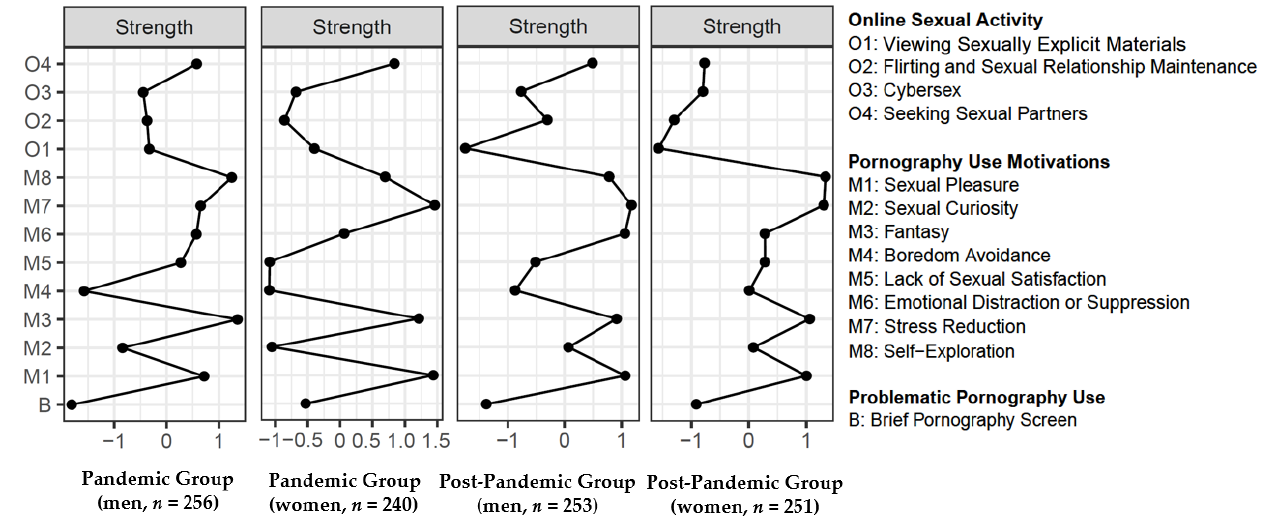
Figure A2. Node centrality plot of strength by gender.